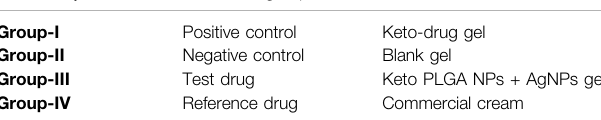
TABLE 7 | Wister albino male rats ’ group for in vivo studies. Group-I